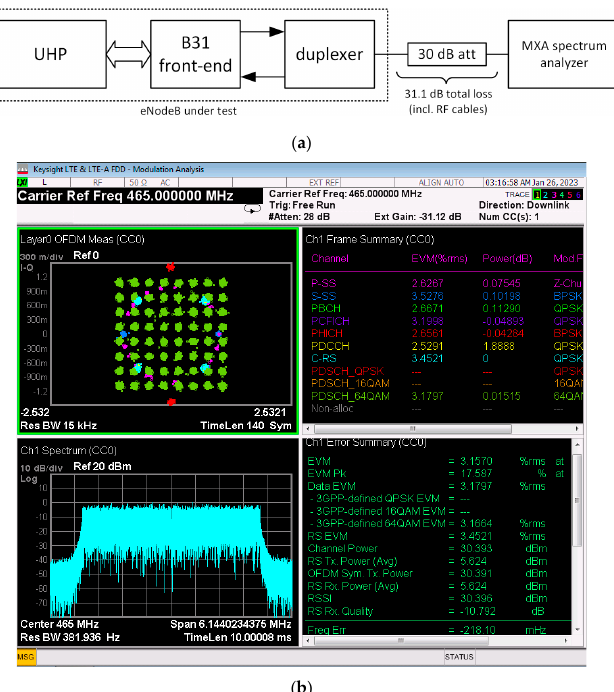
Figure 10. Measurement of transmitted signal quality in FDD, 5 MHz, B31 configuration: ( a ) test fixture block diagram, ( b ) transmitted signal quality measured using the MXA spectrum analyzer with the PathWave Vector Signal Analysis (89600 VSA) software package.